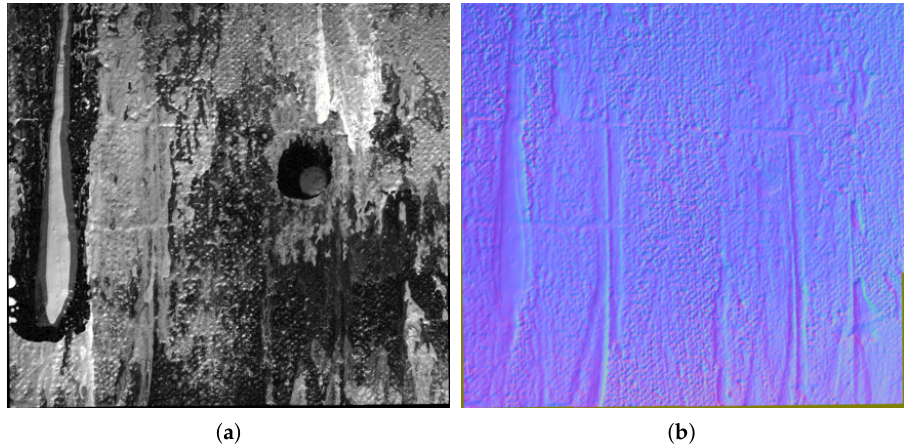
Figure 9. The acquired data are stitched to reconstruct the whole canvas painting. Visualization of the relighted image, normal map and directional slope obtained by processing of the RTI data using DMD [4] model fitting. ( a ) Relighted image. ( b ) Normal